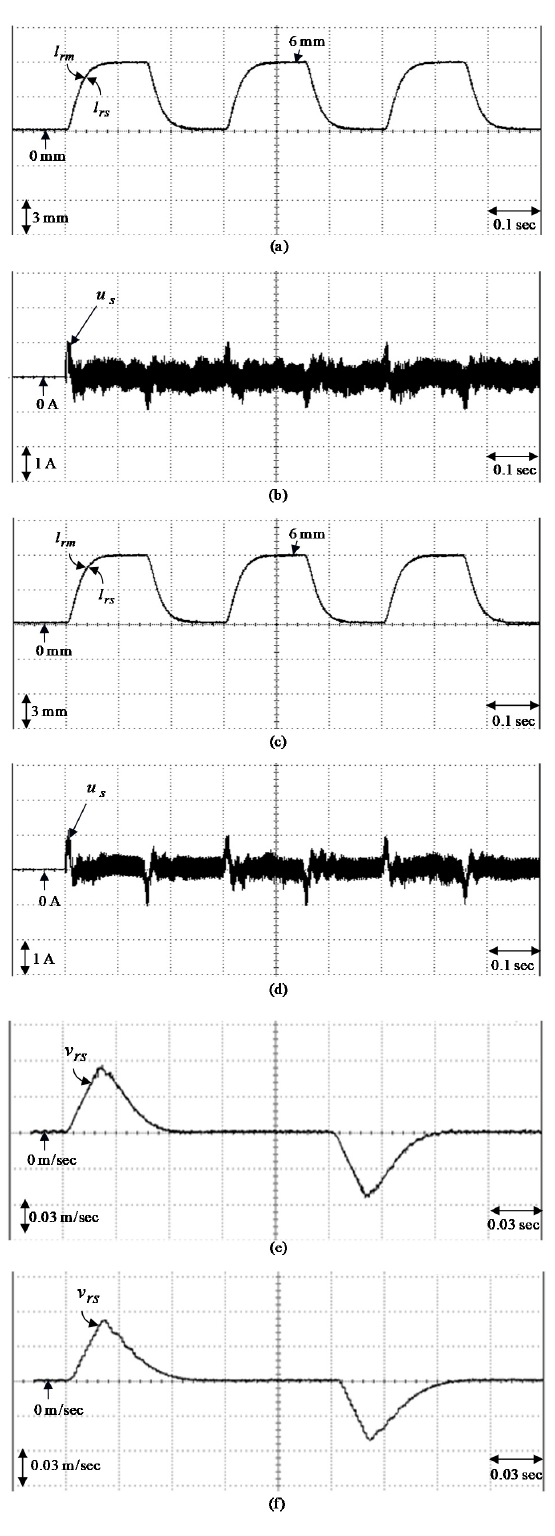
Figure 10. Tested results utilized by the control system K2: ( a ) mover position response at Situation Q1, ( b ) control propulsion response at Situation Q1, ( c ) mover position response at Situation Q2, ( d ) control propulsion response at Situation Q2, ( e ) mover velocity response at Situation Q1, ( f ) mover velocity response at Situation Q2.